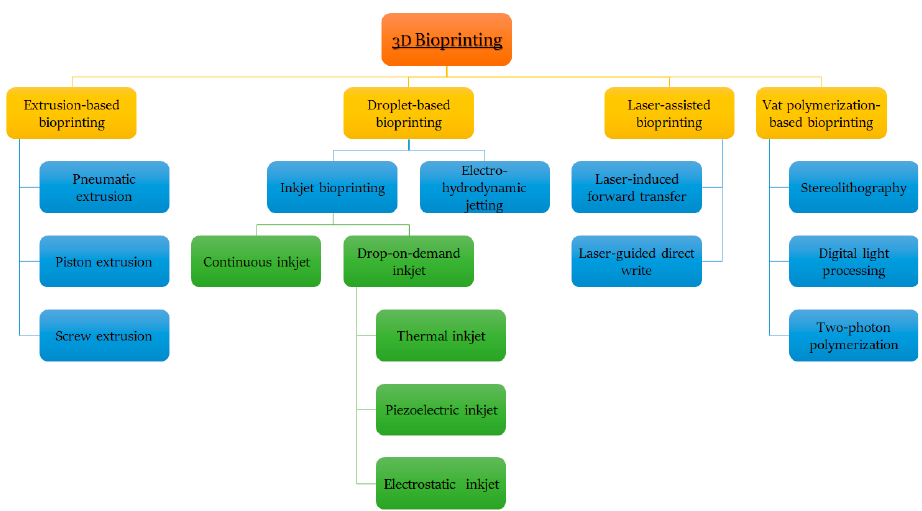
Figure 3. Detailed classification of the major scaffold-based 3D bioprinting: extrusion-based, drop- let-based, laser-assisted and vat polymerization-based bioprinting. based, laser-assisted and vat polymerization-based